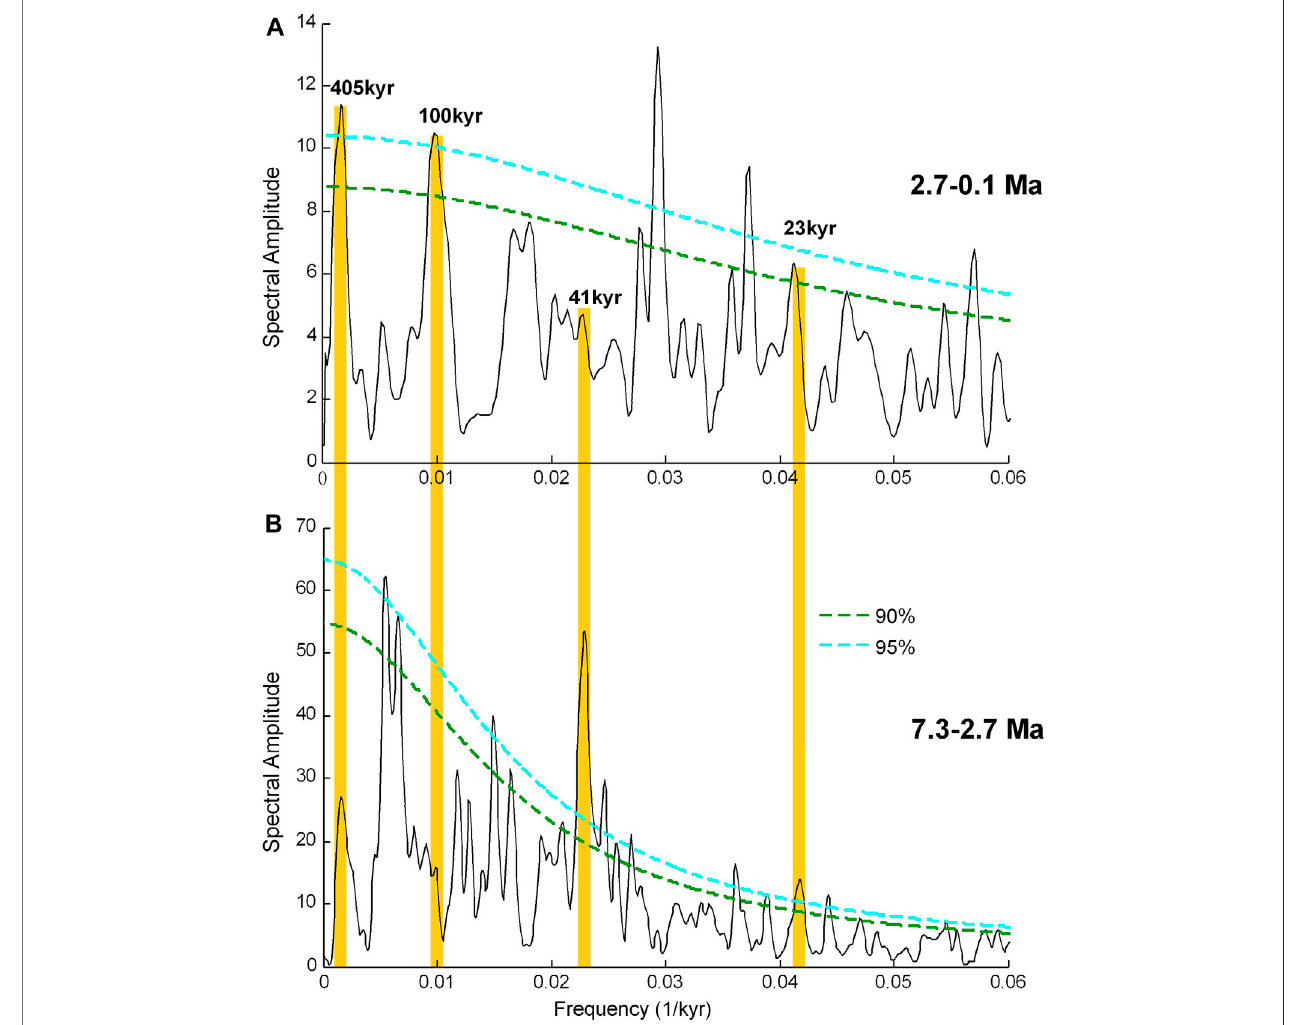
FIGURE 8 | Spectral analysis of the carbonate Mn recordafter 2.7 Ma (A) and before 2.7 Ma (B) . Green and blue dashed lines are 90 and 95% signi fi cance levels, respectively.